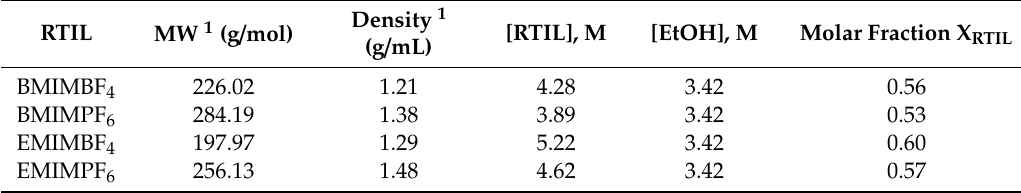
Table 3. Composition of the di ff erent reaction mixtures EtOH / RTIL (1 mL / 4 mL, V / V). Density 1 RTIL MW 1 (g / mol) [RTIL], M [EtOH], M Molar Fraction X RTIL (g / mL) BMIMBF 4